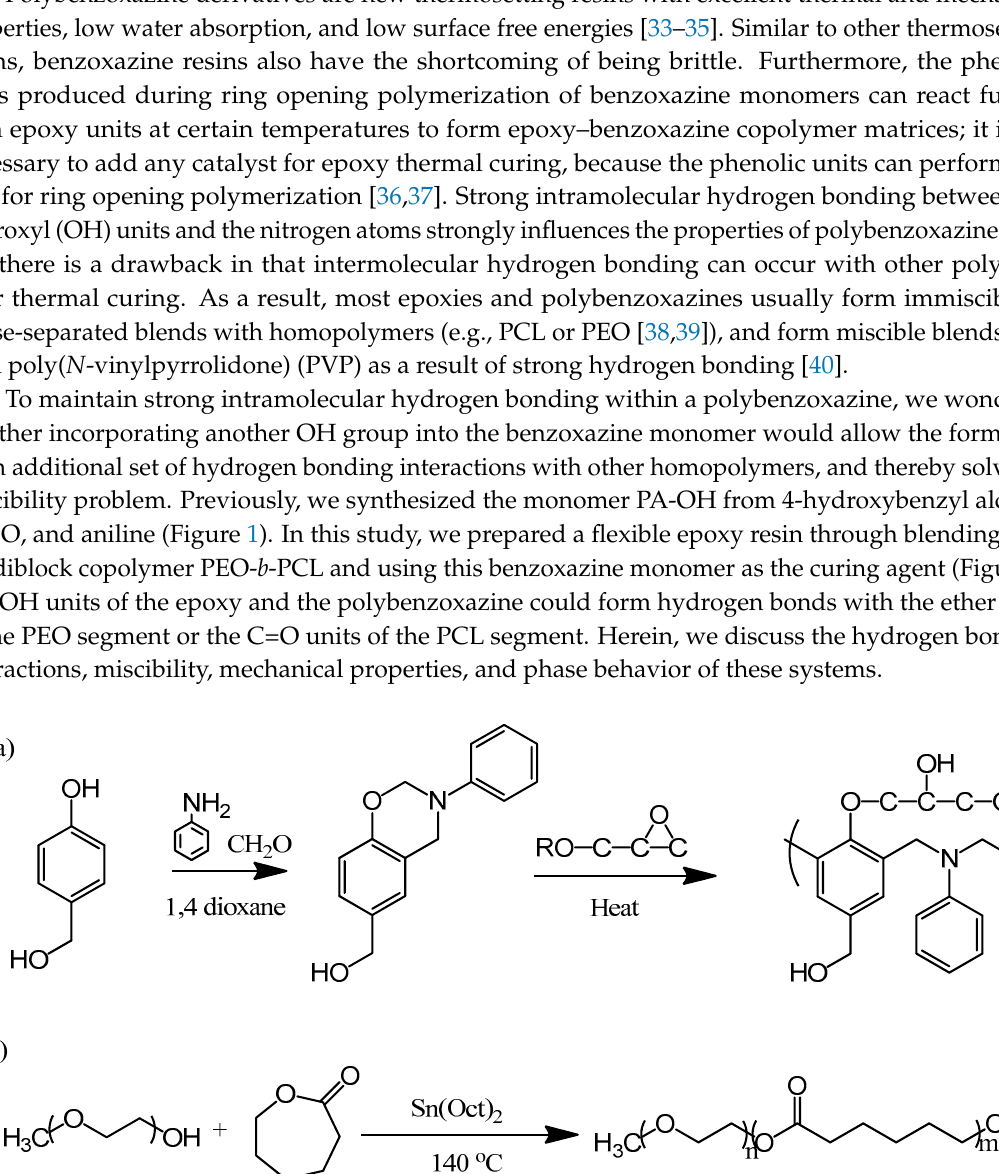
Figure 1. ( a ) Synthesis of the benzoxazine monomer PA-OH and a possible crosslinking structure for the epoxy resin. ( b ) Synthesis of the diblock copolymer PEO ‐ b ‐ PCL.